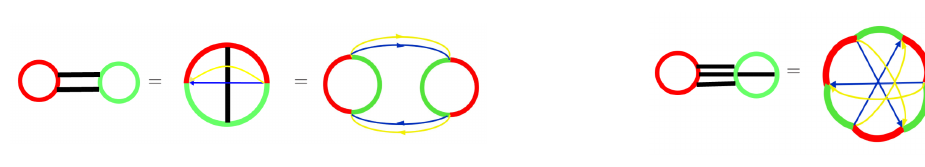
Figure 3. Diagrams of tree operators.